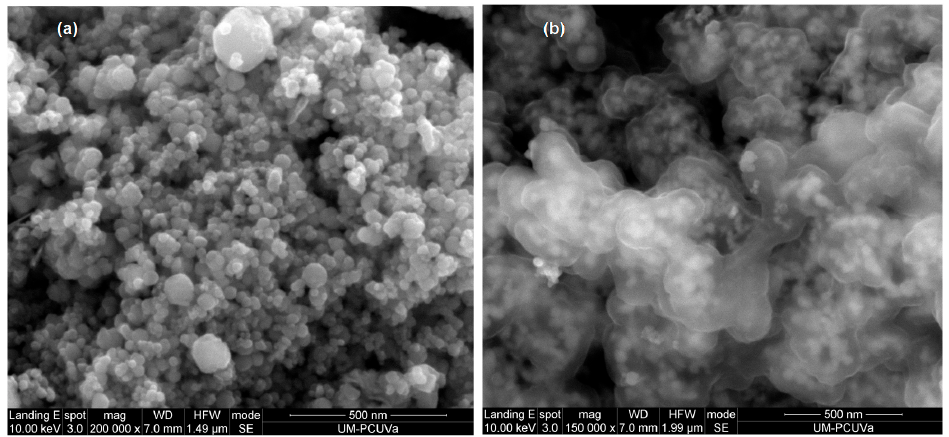
Figure 3. SEM images obtained of the synthesized adsorbents. ( a ) Fe 3 O 4 ; ( b ) coated Fe 3 O 4 .